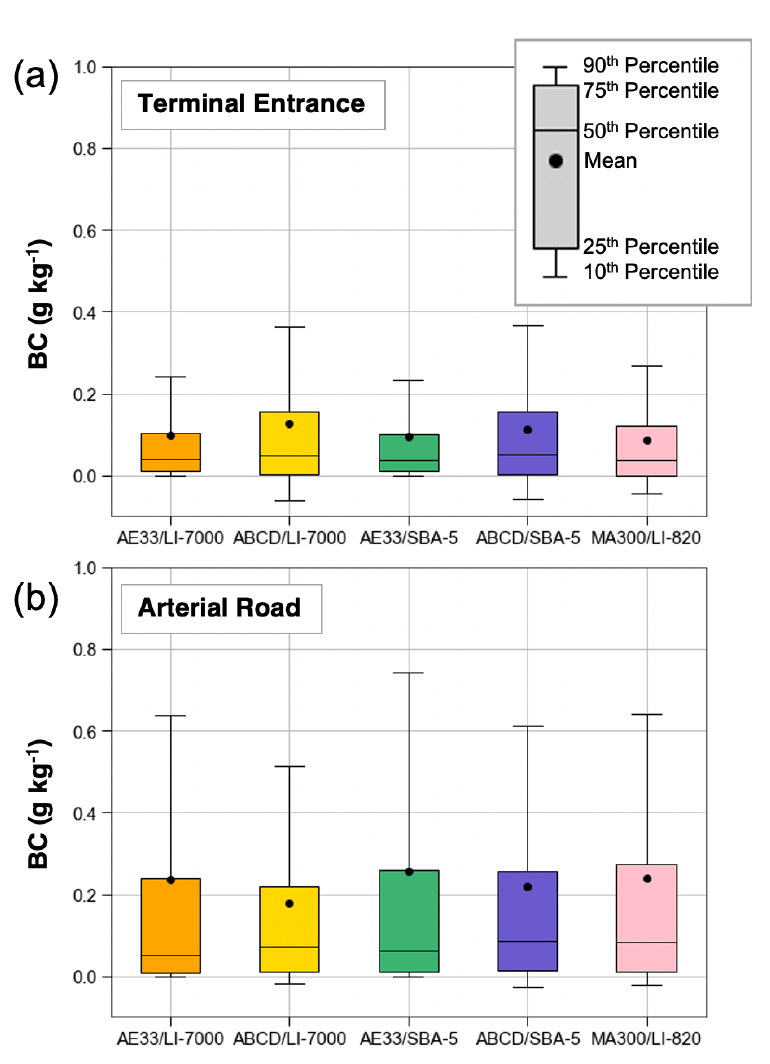
Figure A6. BC emission factors distributions measured at the ( a ) Terminal Entrance and ( b ) Arterial Road for five di ff erent sensor